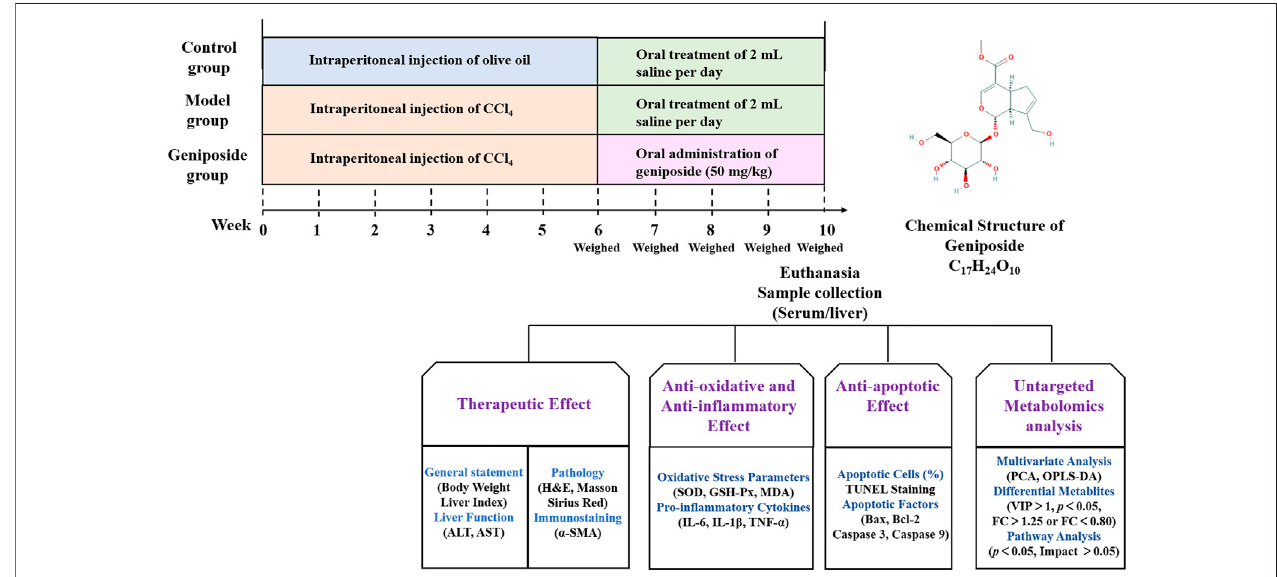
FIGURE 1 | Overview of the experimental design for all groups.